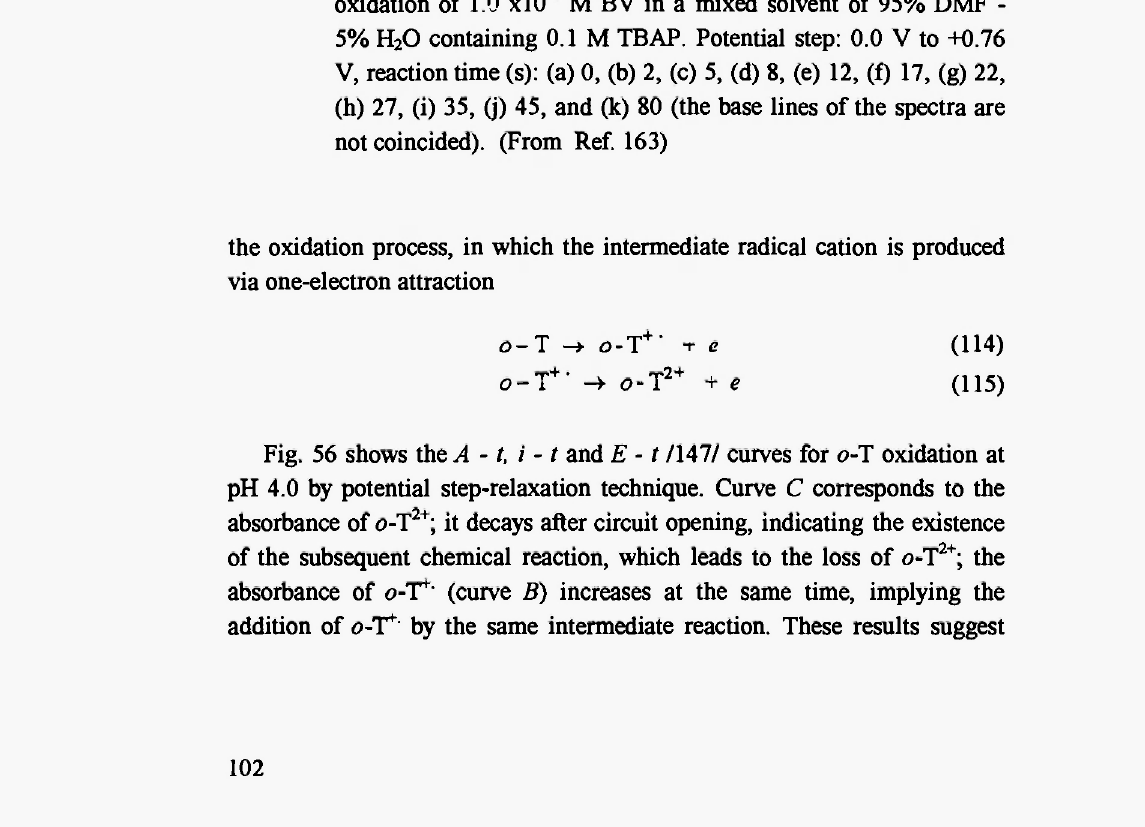
Fig. 54: Time-resolved absorption spectra changes for electrochemical oxidation of 1.0 xlO" 4 Μ BV in a mixed solvent of 95% DMF - 5% H 2 0 containing 0.1 Μ TB ΑΡ. Potential step: 0.0 V to +0.76 V, reaction time (s): (a) 0, (b) 2, (c) 5, (d) 8, (e) 12, (f) 17, (g) 22, (h) 27, (i) 35, (j) 45, and (k) 80 (the base lines of the spectra are not coincided). (From Ref.